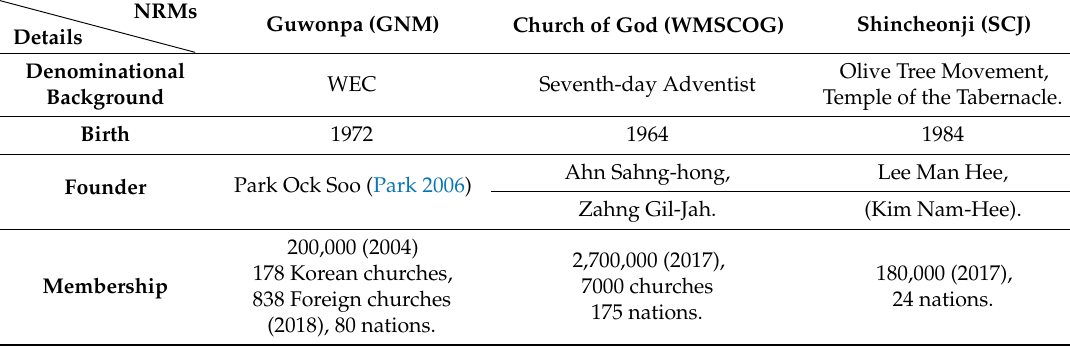
Table 1. A comparative study of three Korean Christian